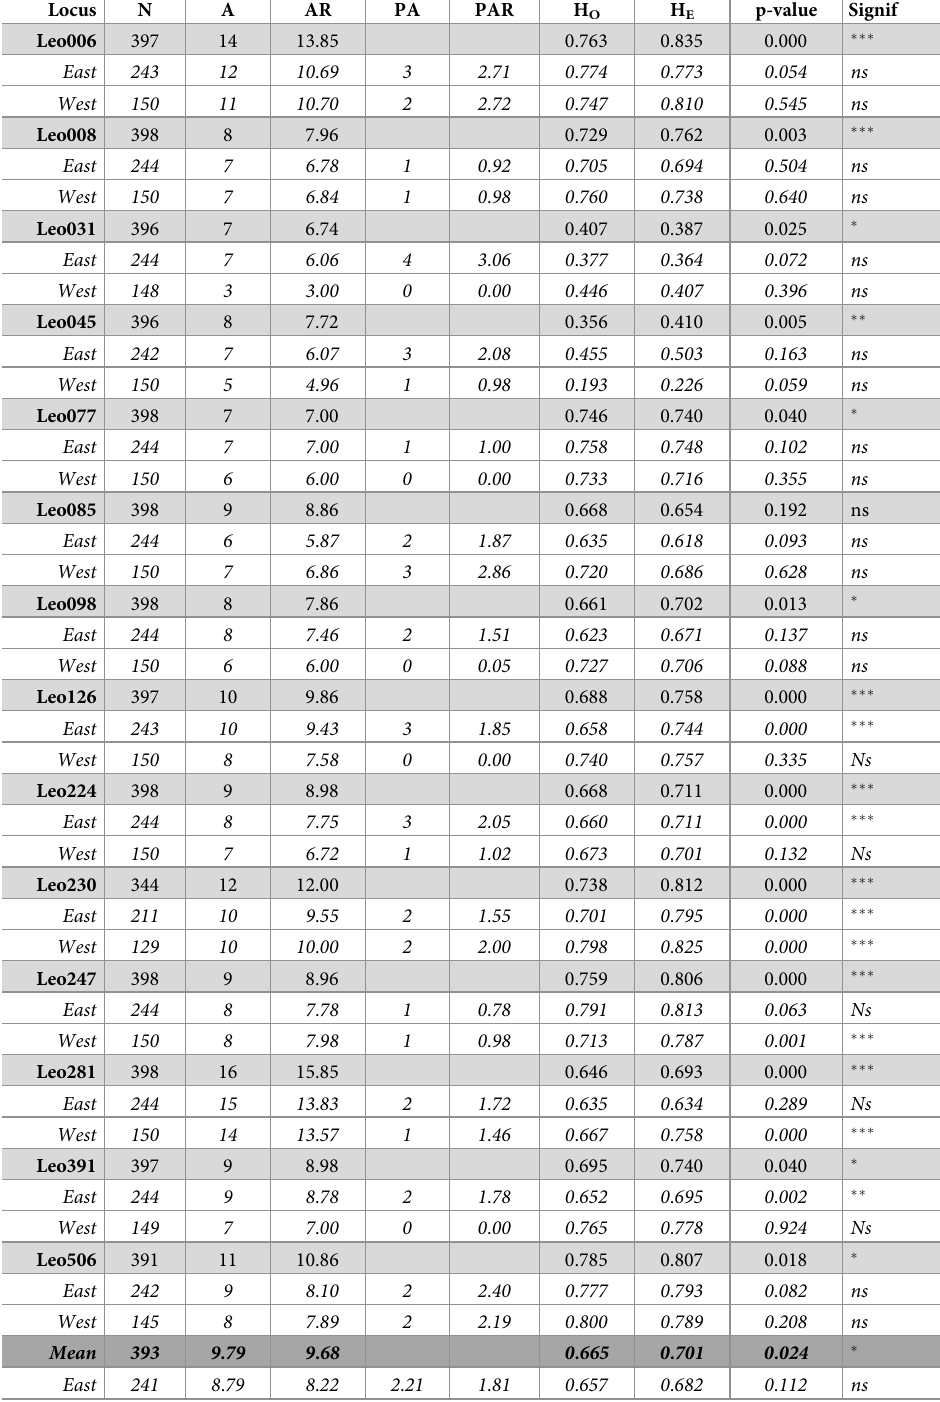
Table 4. STR diversity